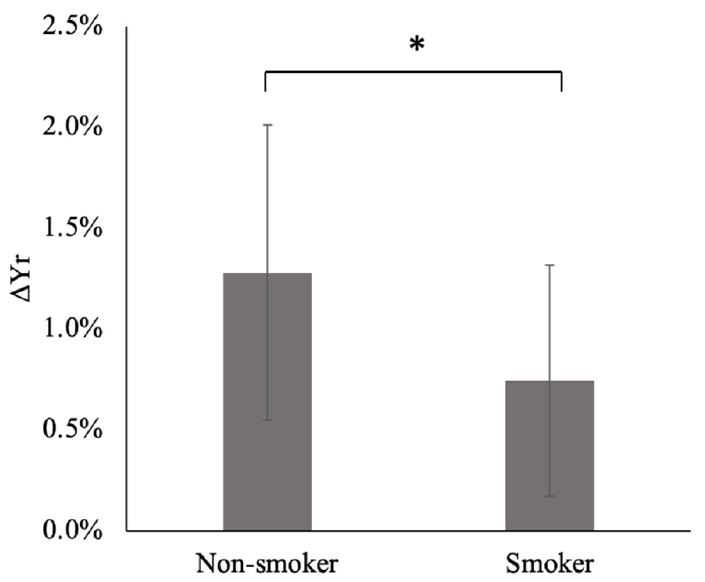
Figure 4. Respiratory changes in venous blood oxygenation ( Δ Y r ) of non ‐ smokers and smokers. The error bars indicate the standard deviation. *: p < 0.05. See Supplementary Material for further details. Table 2. Results of physiological parameters. Physiological